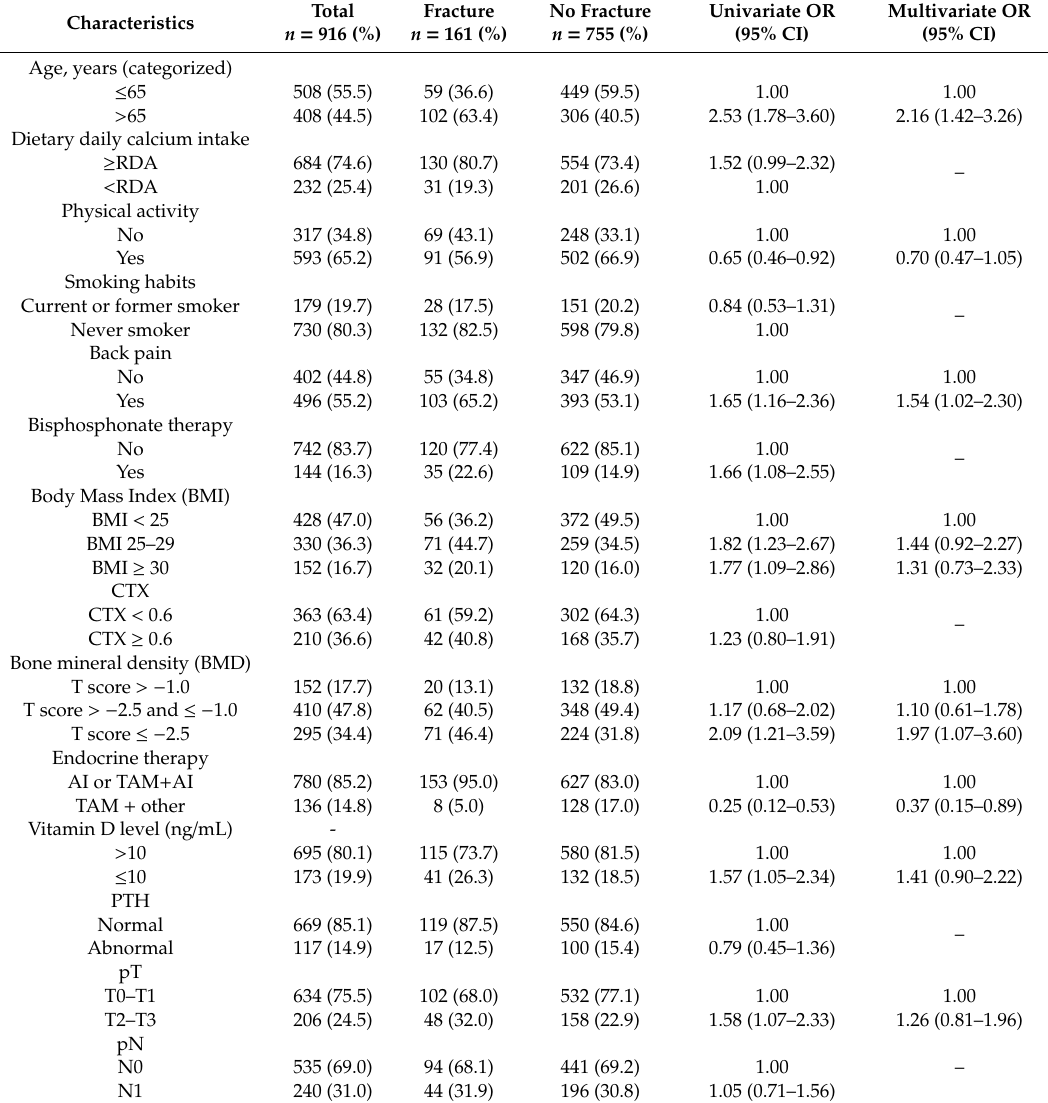
Table 3. Univariate and multivariate risk of morphometric vertebral deformities in post-menopausal